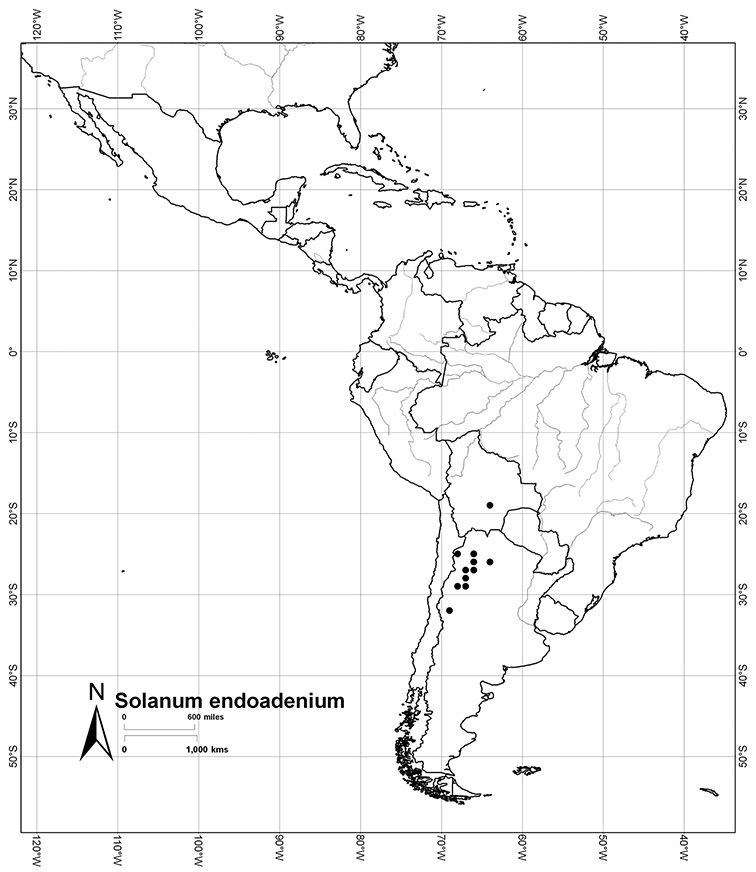
Distribution of Solanum endoadenium Bitter.